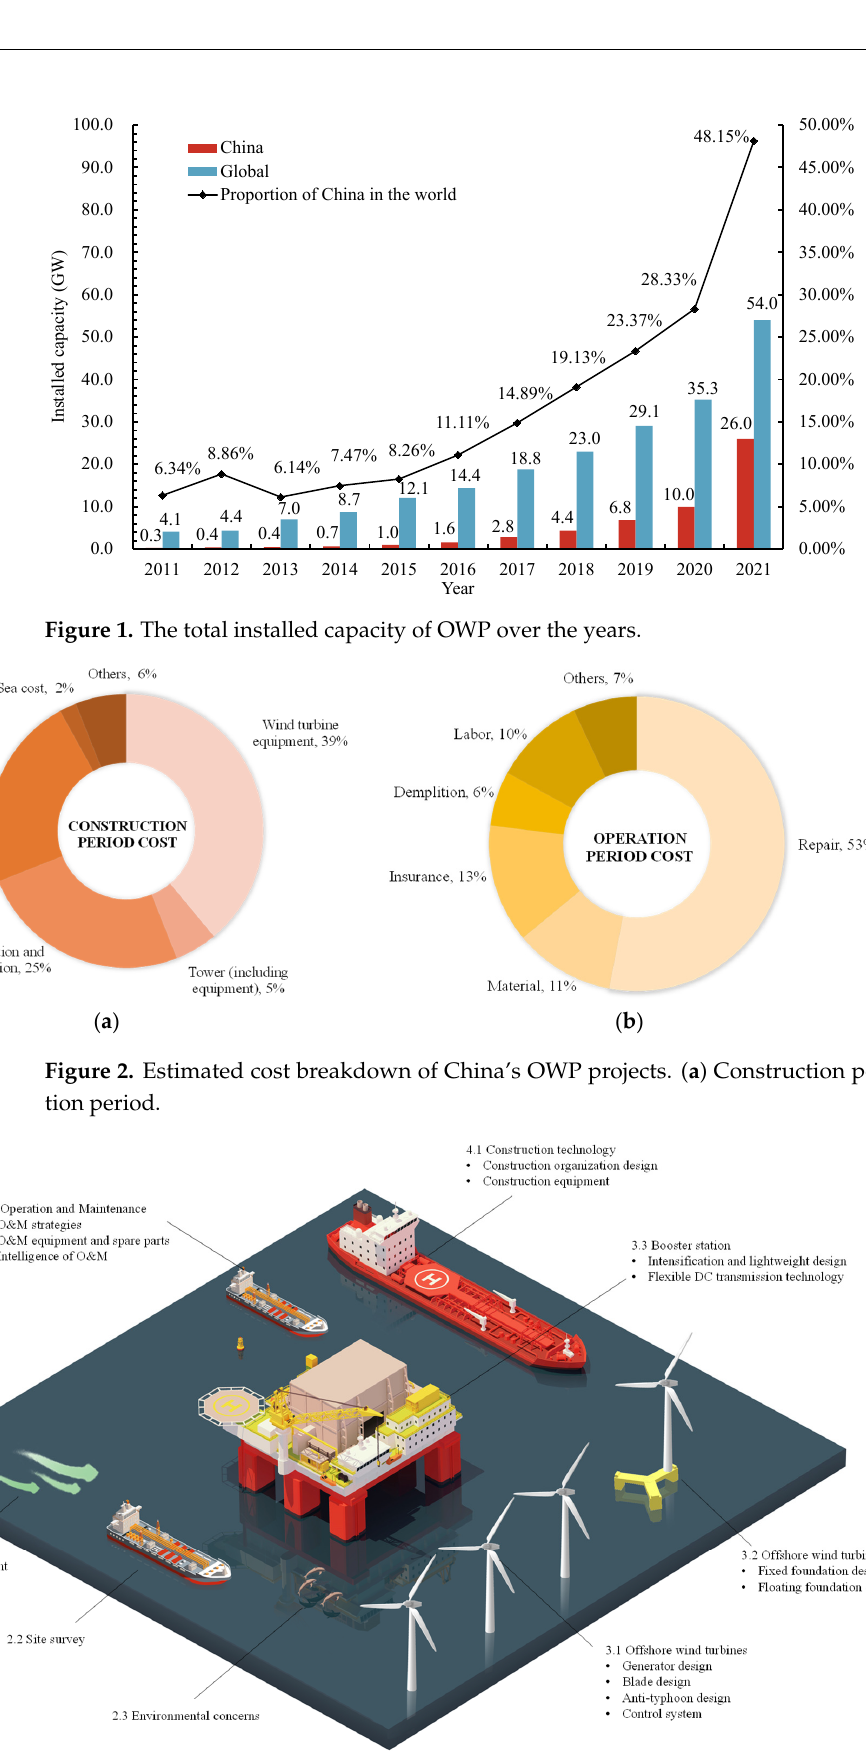
Figure 3. Key technologies in an offshore wind farm.